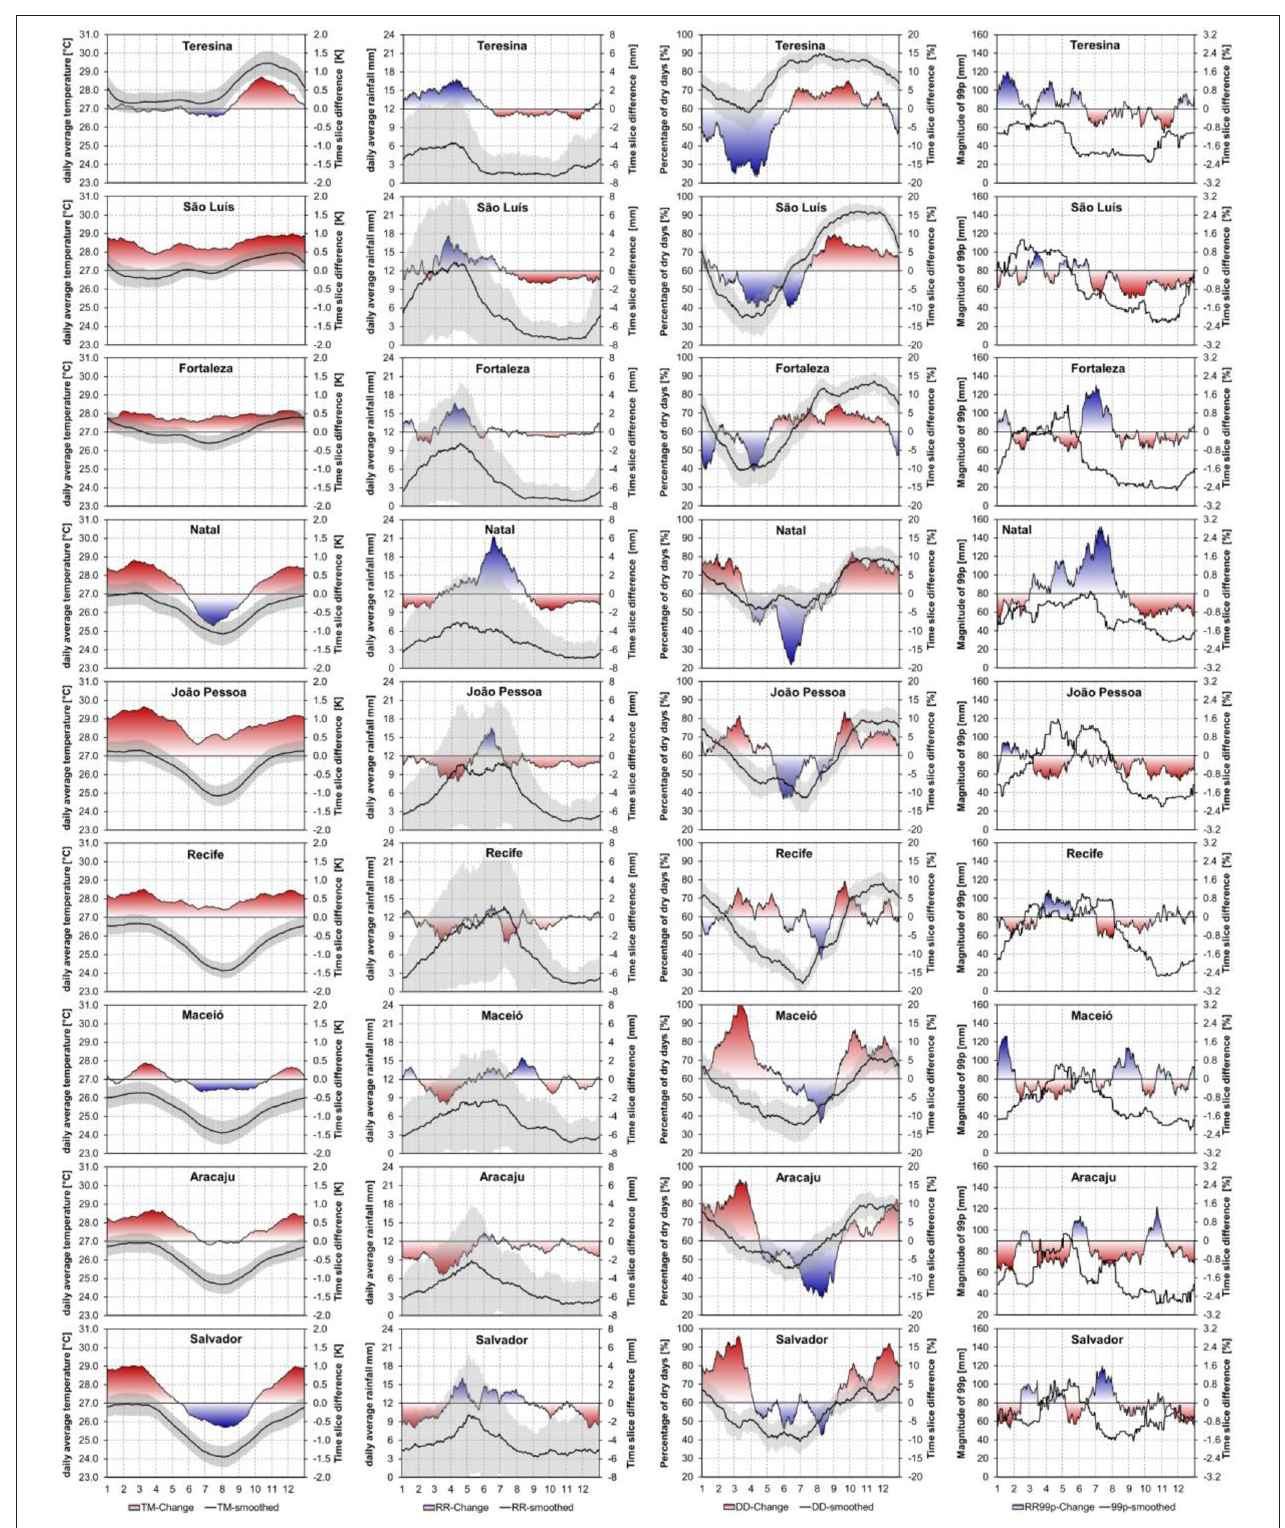
FIGURE 5 | Seasonal cycle of low-pass filtered (31-days moving average) daily average temperature (TM, first row), precipitation (RR, second row), dry day (DD, third row), and heavy precipitation (99th percentile, fourth row) frequency at nine stations in NEB within 1961–1990 as well as change in the seasonal cycle in 1991–2011 as compared to 1961–1990. Gray shaded areas indicate the temporal variability (standard deviation) of TM, RR, and DD.